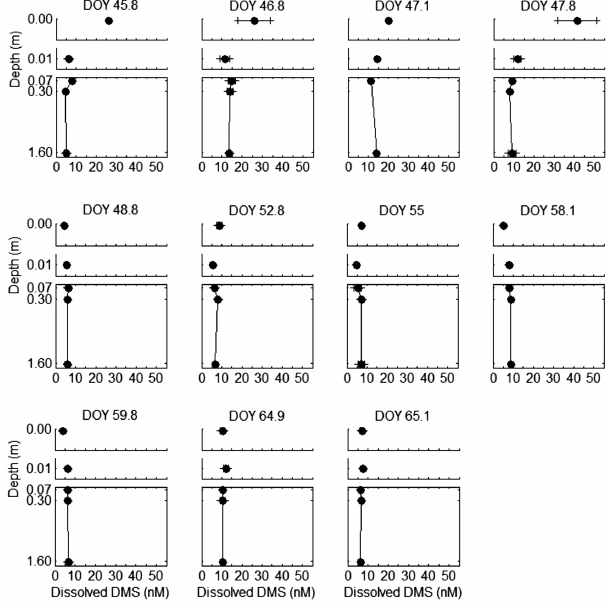
Figure 4. Near-surface gradients of [DMS] in the SSM and in the upper 1.6m. Measurements presented are the mean replicate sam- ples, and error bars represent 1 standard